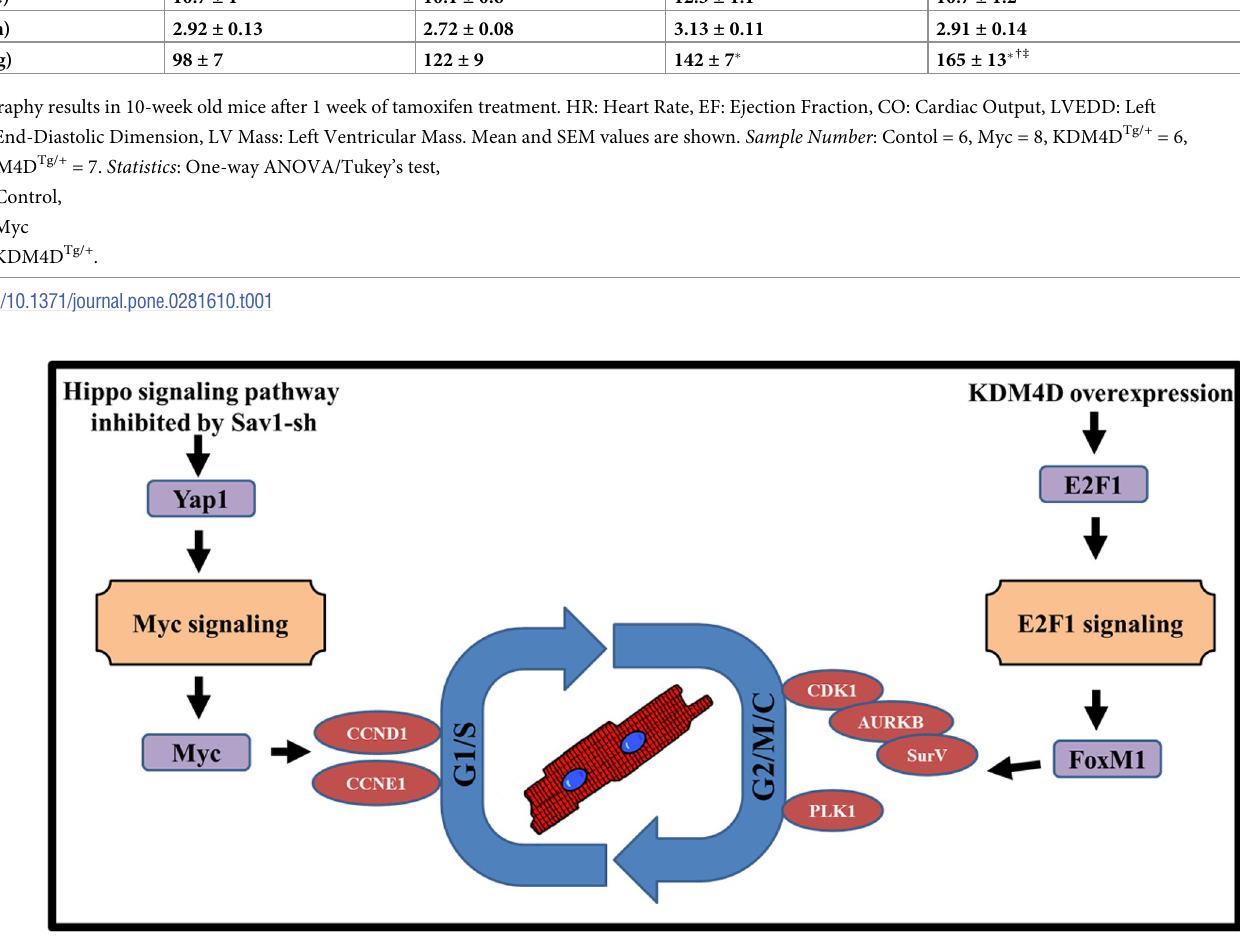
Fig 8. Proposed model for KDM4D and Hippo signaling pathway in the regulation of cell cycle activities. KDM4D preferentially induced expression of genes regulating late (G2/M) phases of the cell cycle by stimulating E2F1 and FoxM1 expression, while miR-199 or Hippo pathway inhibition preferentially up-regulated genes involved in G1/S phase by stimulating Myc